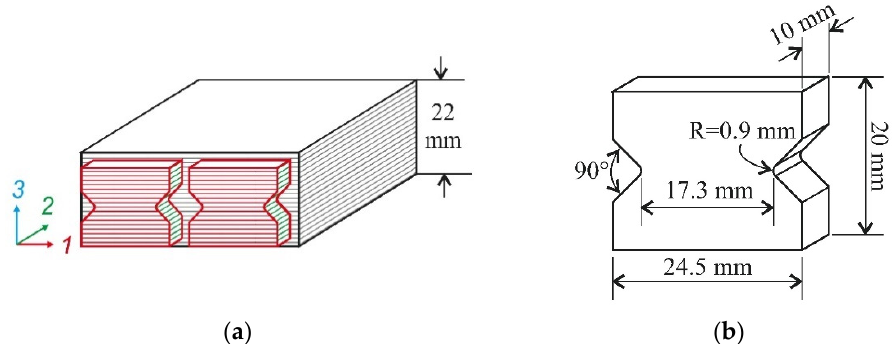
Figure 3. Cutting scheme ( a ) and dimensions of the specimens ( b ).